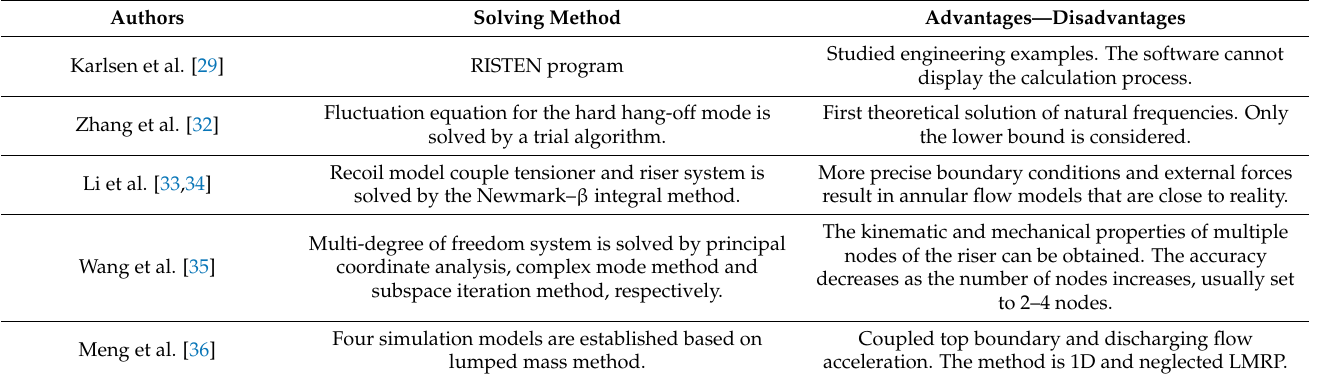
Table 1. The comparison of riser recoil models.